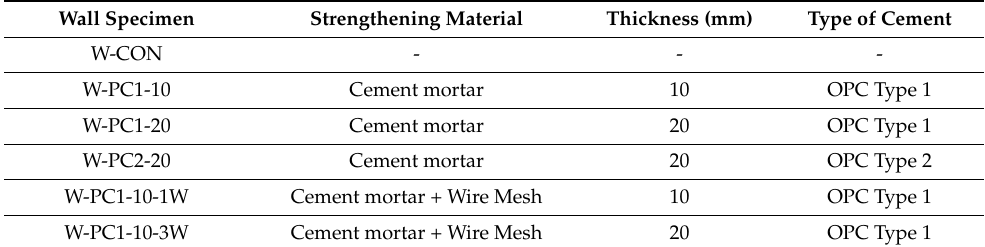
Table 1. Details of CCIHBM walls.